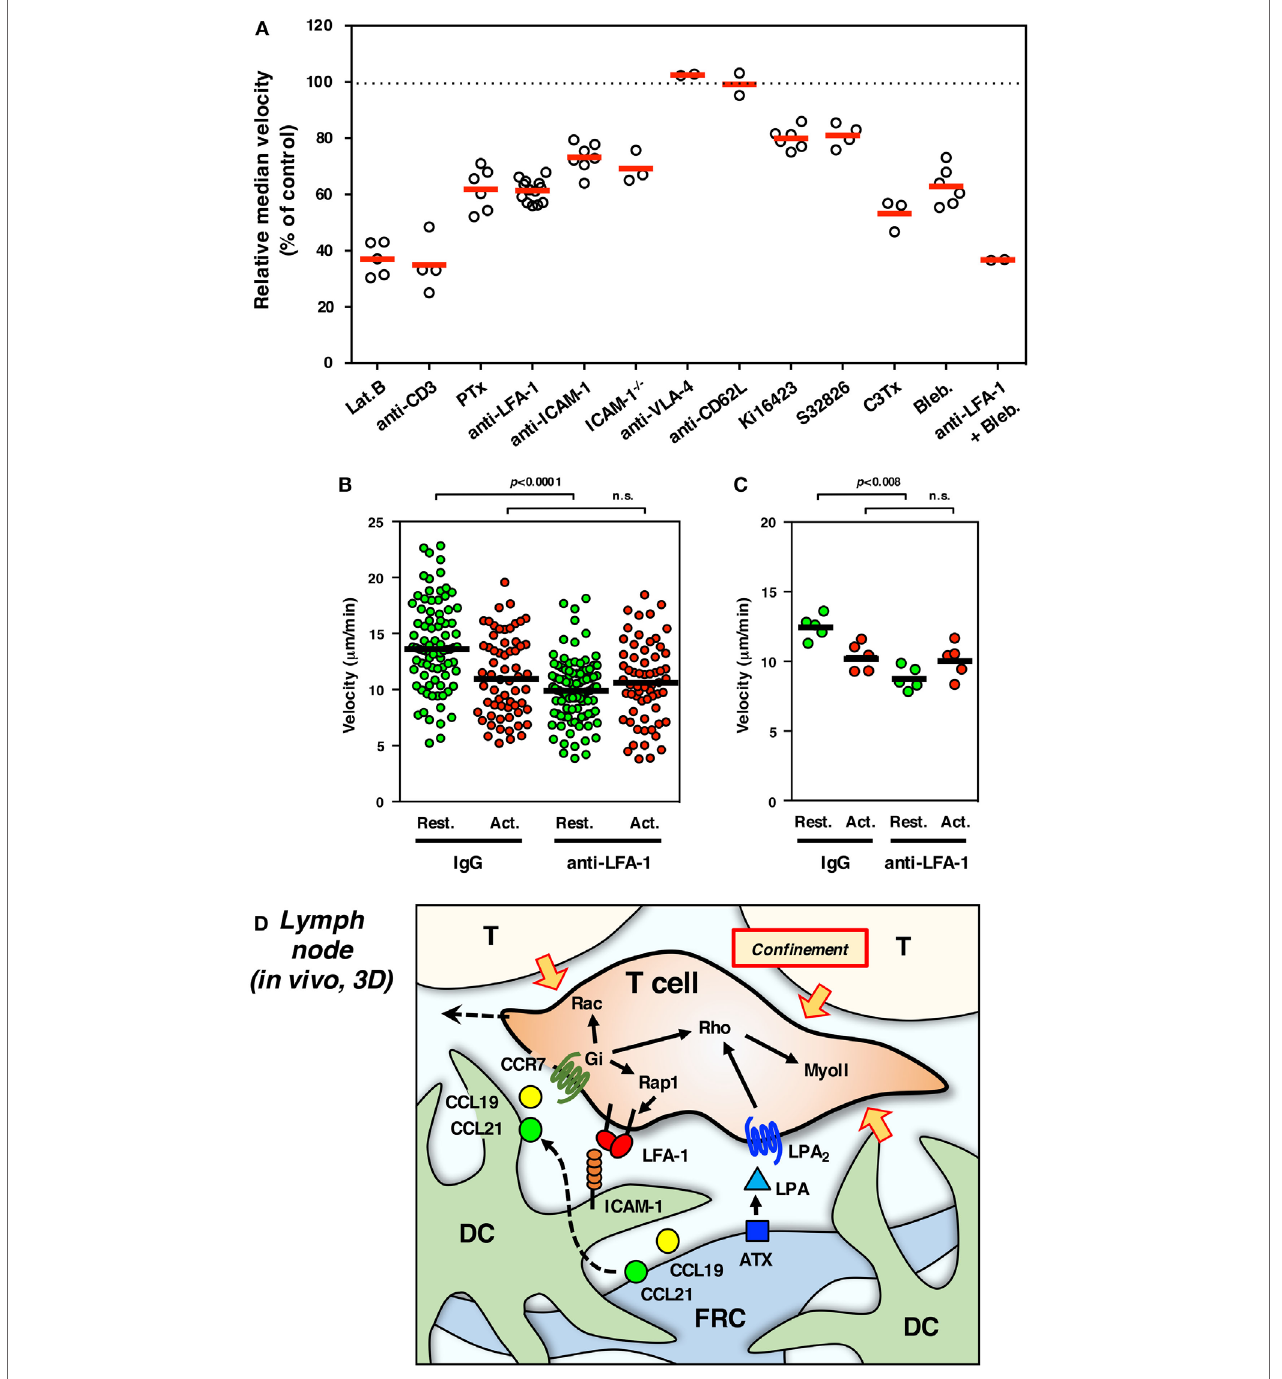
FiGUre 2 | interstitial t cell migration in LN . (A) Various treatments affect T cell migration in LN slices [partially adapted and modified from Ref. (27, 54)]. The circles represent the migration velocity (%) compared to the control in each experiment, and the horizontal red bars represent the mean ( n ≧ 2). Lat.B, latrunclin B (actin inhibitor); Ki16425, LPAR inhibitor; S32826, ATX inhibitor; C3Tx, C3 toxin (Rho inhibitor); Bleb., blebbistatin (nmMyoII inhibitor). (B,c) Migration velocities of resting (Rest., green) and activated (Act., red) T cells in LN slices in the presence of control IgG or anti-LFA-1 antibody. The plot in (B) shows the mean velocity of individual cells (circles) and the median (horizontal bars), while the plot in (c) shows the median velocity for individual experiments (circles) and the mean of five experiments ( n = 5, horizontal bars). For activation, total T cells isolated from LNs were stimulated with immobilized anti-CD3 and soluble anti-CD28 antibodies for 3 days. Freshly isolated resting T cells and activated T cells were labeled with different fluorescent dyes (CFSE and CMTMR), mixed at equal numbers, and applied to LN slices for the examination by two-photon laser scanning microscopy. The trajectory data sets of resting and activated T cells in each treatment were obtained